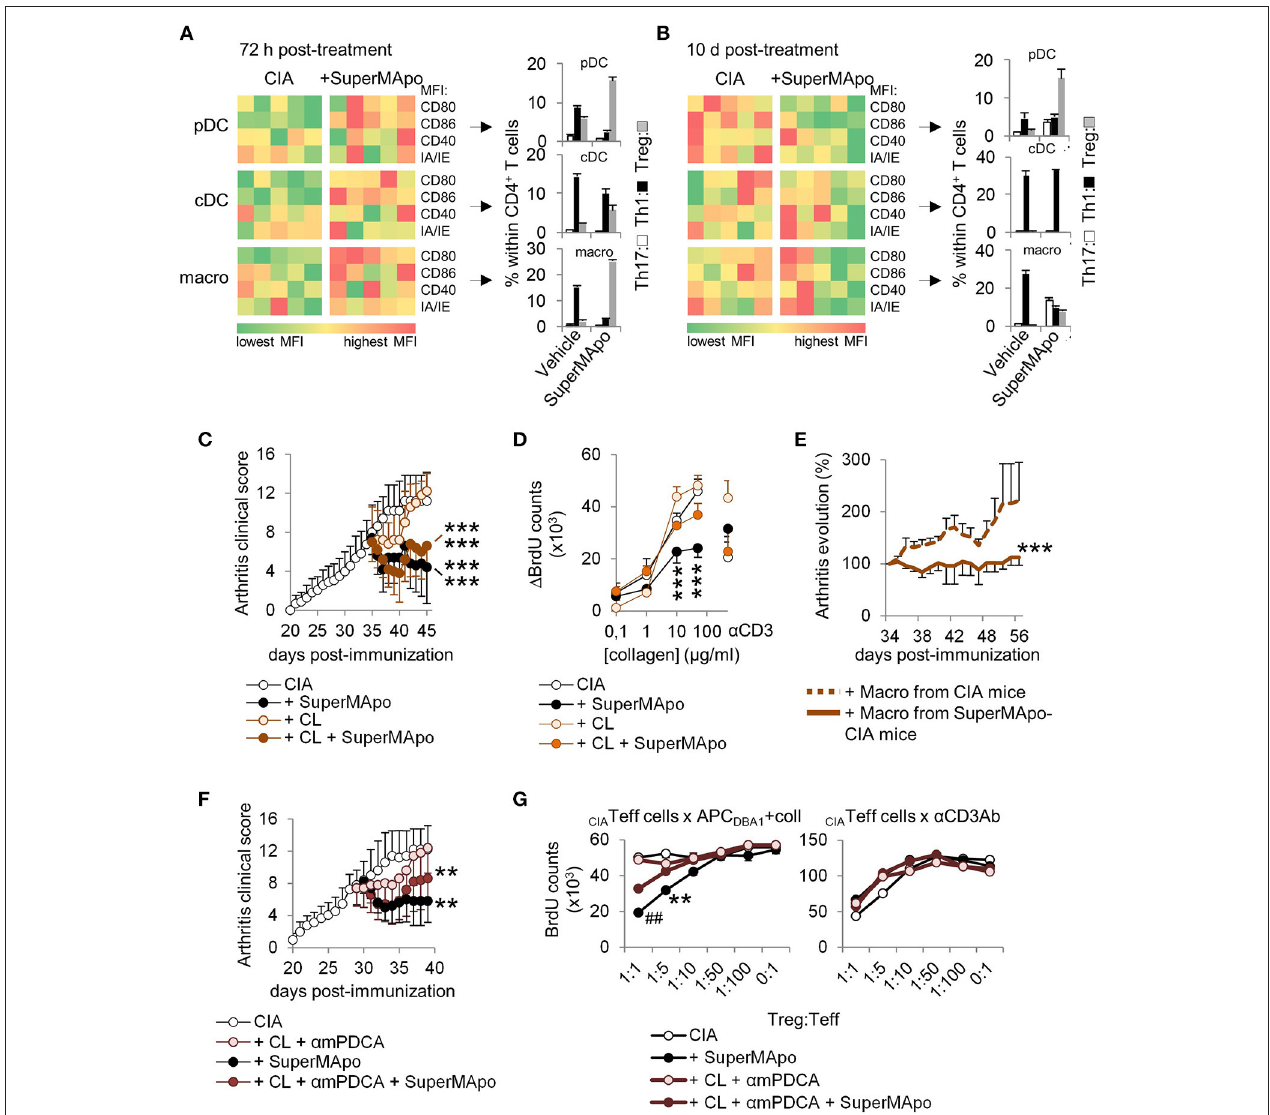
FIGURE 4 | Antigen-presenting cells demonstrate reprogramming in vivo after SuperMApo treatment of CIA mice. (A,B) Costimulatory (CD80/CD86/CD40) and MHC-II molecule (IA/IE) mean florescence intensity (MFI) expressions, evaluated in spleen plasmacytoid DC (pDC), conventional DC (cDC) and macrophages (macro) 72h and 10 days after SuperMApo or vehicle treatment of arthritic mice. Data from representative experiments showing cell marker expression from individual mouse (5 mice per group). Th17, Th1 and Treg CD4 + T cell polarizations by the same APC are also shown (bars represent mean ± s.e.m. of triplicates of APC isolated from each mouse and cultured with naïve CD4 + T cells). (C) Arthritis clinical score of mice receiving SuperMApo treatment or vehicle and clodronate-loaded (CL) or control liposomes (mean ± s.e.m., 5 mice per group). *** P < 0.001 vs. respective control groups (CIA & CIA + CL), one-way ANOVA with Bonferroni’s multiple comparison post-tests. (D) BrdU counts showing the proliferation of cells from arthritic mice 72h after receiving SuperMApo or vehicle and phagocyte depletion, in response to increasing doses of collagen or to CD3-specific antibody (as control). Data are shown as mean ± s.e.m. of cell triplicates, 5 mice per group, *** P < 0.001, 2-way ANOVA with Bonferroni post-tests. (E) Evolution of arthritis clinical score (in percentage; 100% = arthritis clinical score the day of injection) in mice with ongoing arthritis (mean arthritis clinical score = 7.1 ± 0.6 the day of cell injection) after receiving macrophages from vehicle- or SuperMApo-treated CIA mice. Percentages of clinical score are shown as mean ± s.e.m., 8 mice per group from 2 independent experiments. *** P < 0.001, Wilcoxon signed rank test. (F) Arthritis clinical score of mice receiving SuperMApo treatment or vehicle with or without clodronate-loaded liposomes and anti-mPDCA antibody (CL + α mPDCA) (mean ± s.e.m., 5 mice per group). ** P < 0.005 for CIA vs. CIA + SuperMApo & CIA vs. CIA + CL + α mPDCA + SuperMApo, one-way ANOVA with Bonferroni’s multiple comparison post-tests. (G) BrdU counts showing collagen-specific suppression of cell proliferation by Treg issued from arthritic mice from F . The suppressive activity of all Treg is also shown as control in CD3-specific antibody-stimulated cultures. Data are shown as mean ± s.e.m. of mouse spleen cells performed in triplicates, 5 mice per group, ## P < 0.005 vs. CL + mPDCA and CIA, ** P < 0.005 vs. CIA, 2-way ANOVA with Bonferroni post-tests. Figure data are issued from representative experiments, repeated at least three times with similar results unless otherwise